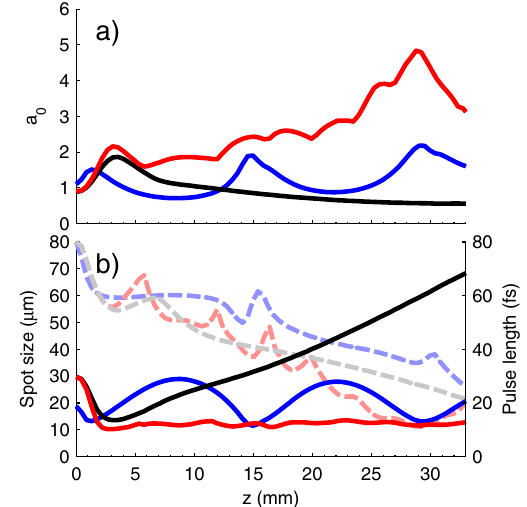
FIG. 5. (Color) Calculated values, as a function of propagation ) (solid) and distance z , of: (a) peak a 0 , (b) mean spot radius ( 1 e 2 FWHM duration (dashed) of laser pulses propagating through a gas cell (black) and a plasma channel (red/blue). For these calculations the channel was parabolic, with n e ð 0 Þ ¼ 1 : 8 (cid:5) 10 18 cm (cid:3) 3 and lowest-order mode of 41 (cid:5) m FWHM, corresponding to P ¼ 80 mbar ; the gas in the cell was fully ionized, with an electron density of n e ð 0 Þ . The temporal and transverse spatial profiles of the input laser pulses were Gaussian, with initial FWHM duration of 80 fs and FWHM focal spots of 35 (cid:5) m (black/red) and 22 (cid:5) m (blue). The input laser energies were adjusted to give the measured input fluences when the total on-target laser energy was 2.5 J, i.e., 2 and 1.2 J with and without the aperture, respectively.